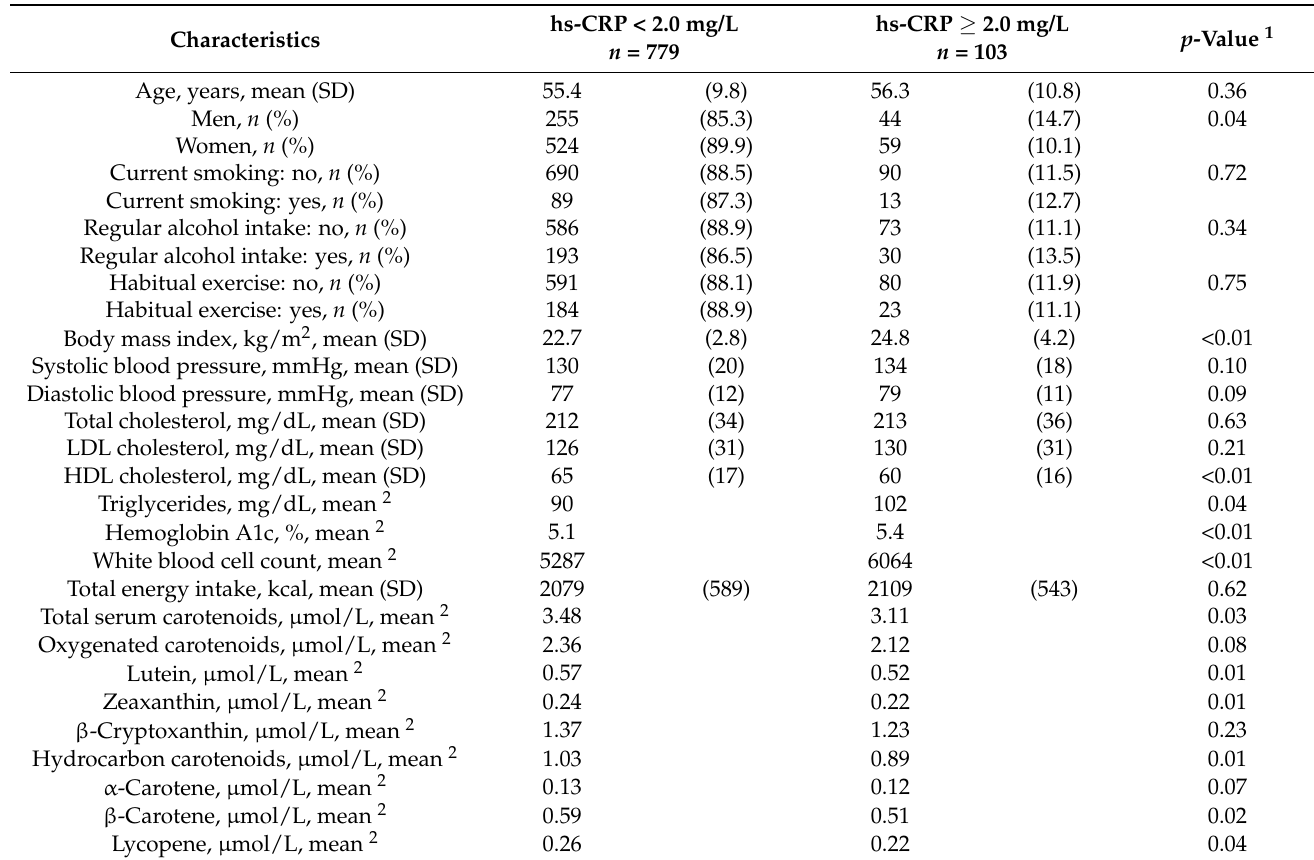
Table 1. Summary of participant demographic characteristics, lifestyle factors, and physical and blood examination findings stratified according to high-sensitivity C-reactive protein